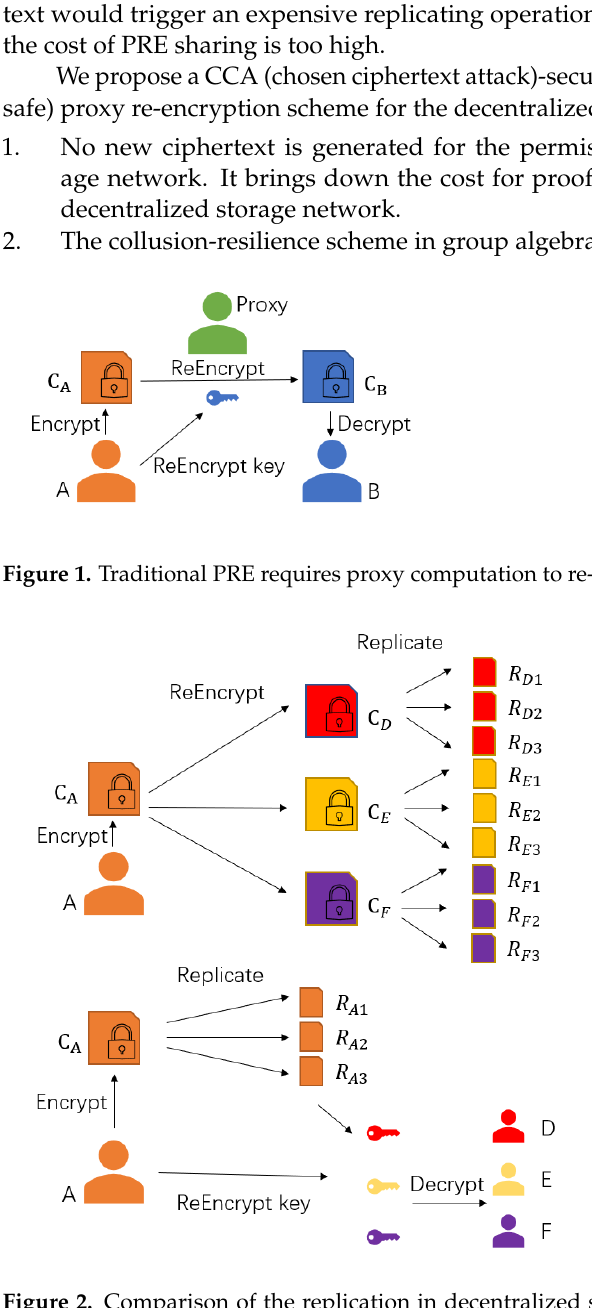
Figure 2. Comparison of the replication in decentralized storage network with or without trans- ferred